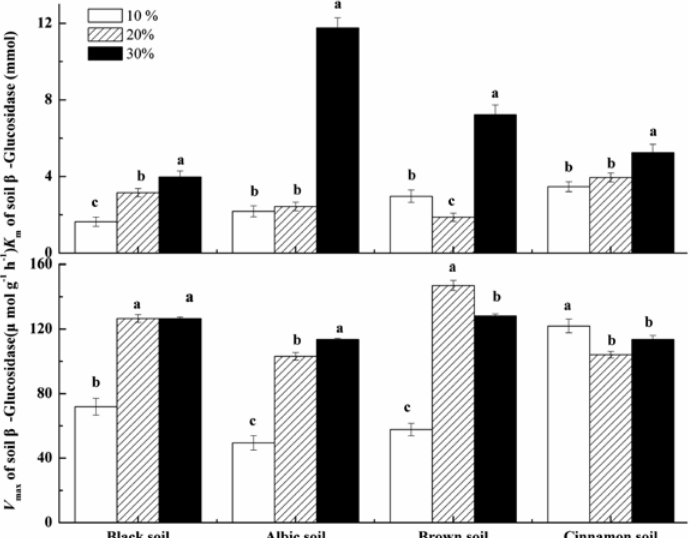
Figure 2. K and V of soil β -glucosidase ( K m max moisture contents.